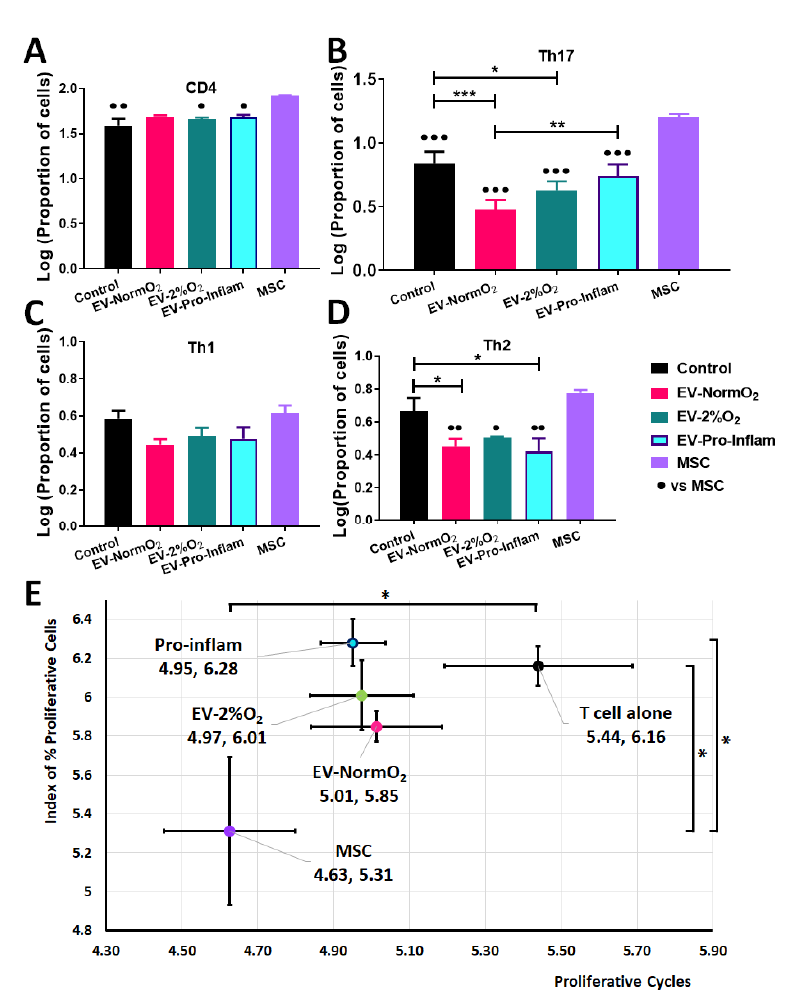
Figure 3. Outcomes of EV treatments co-cultured with T cells isolated from healthy murine spleens ( A ) Increased CD4+ T cells in MSC co-cultures compared to EV-2%O 2 ; EV-Pro-Inflam; and T cells alone control ( B ) Increased pro-inflammatory Th17 cells (IL17a+) in MSC co-cultures over to EV- NormO 2 ; EV-2%O 2 ; EV-Pro-Inflam; and T cells alone control with EV-NormO 2 significantly reduced on PBS control and EV-Pro-Inflam also ( C ) EV or MSC treatments did not alter Th1 polarisation ( D ) EV treatments all reduced Th2 polarisation in comparison to MSC treatment, with EV-NormO 2 and EV-Pro-Inflam also reduced in comparison to PBS controls (Index of proliferation only) ( n = 3; * p < 0.05; ** p < 0.01; *** p < 0.001; 1-way ANOVA with Bonferroni post-hoc of log-transformed data. ( E ) MSC co-cultures significantly inhibited T cell proliferation compared with T cells cultured alone (both measures) and EV-Pro-Inflam co-culture (Index of proliferation only) ( n = 3; * p < 0.05; 1-Way ANOVA with Bonferroni post-hoc of log-transformed